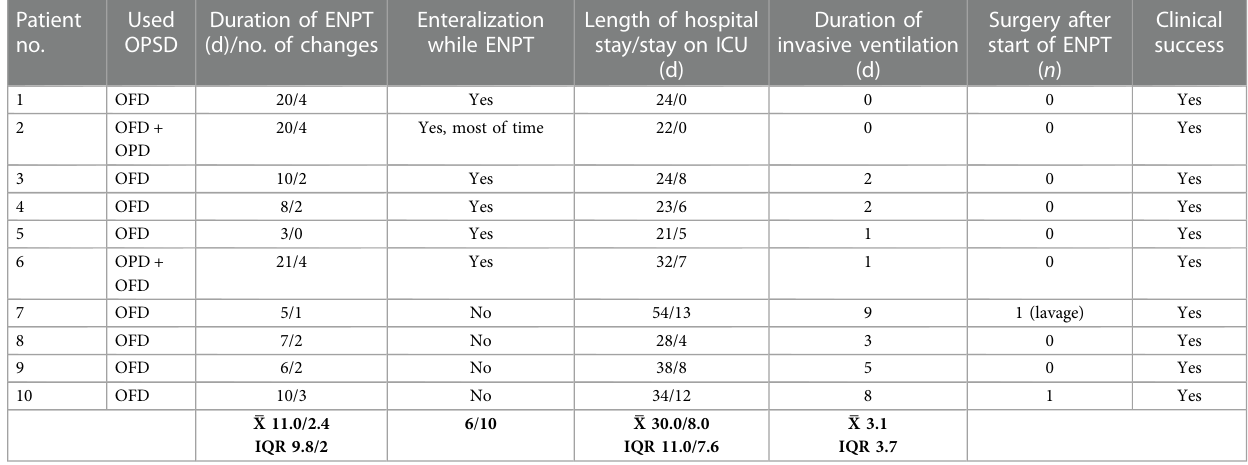
TABLE 2 Therapeutic data of the included patients treated with ENPT for duodenal leaks. Patient